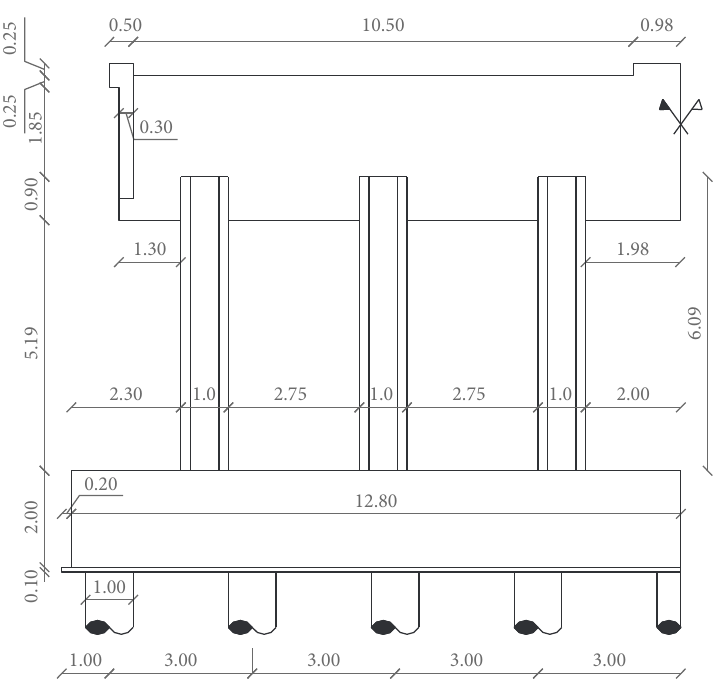
Figure 3: Lateral view of the abutment